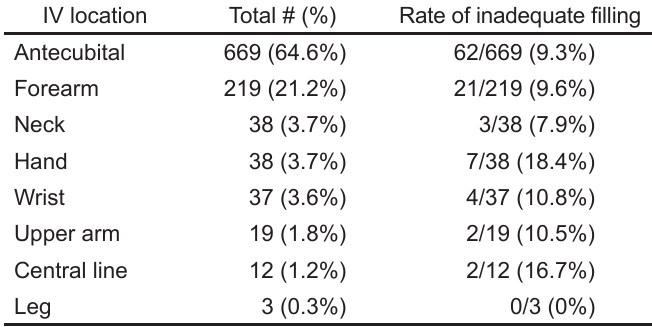
Table 2. Intravenous (IV) catheter location and rate of inadequate pulmonary vasculature filling.